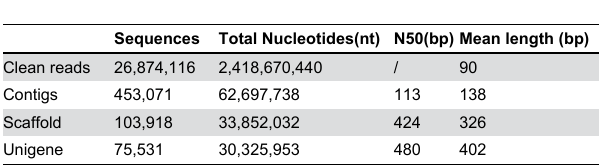
Table 1. Statistics for output of RNA-seq and reads assembly of the C. sinensis floral transcriptome.